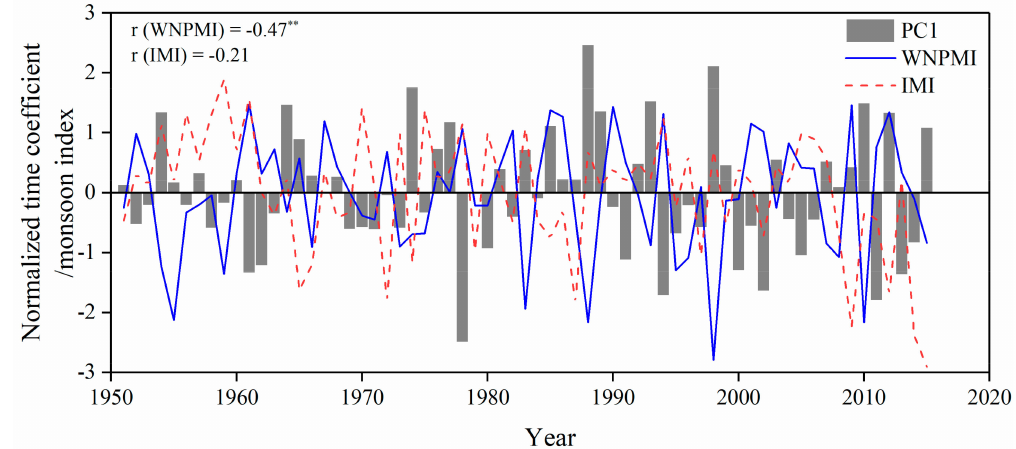
Figure 6. The variation of the first principal component (PC1), western North Pacific summer monsoon index (WNPMI), and Indian summer monsoon index (IMI) during JJAS of 1951–2015. The r is the correlation coe ffi cient, and ** denotes statistical significance at the 99% confidence